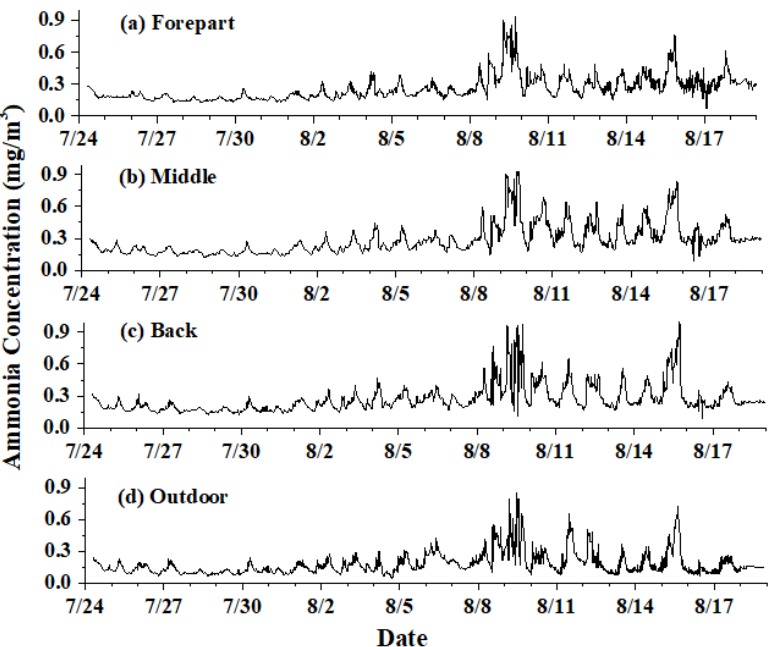
Figure 6. Variation of ammonia concentration in the pig house in summer. ( a ) Forepart; ( b ) Middle; ( c ) Back; ( d ) Outdoor.